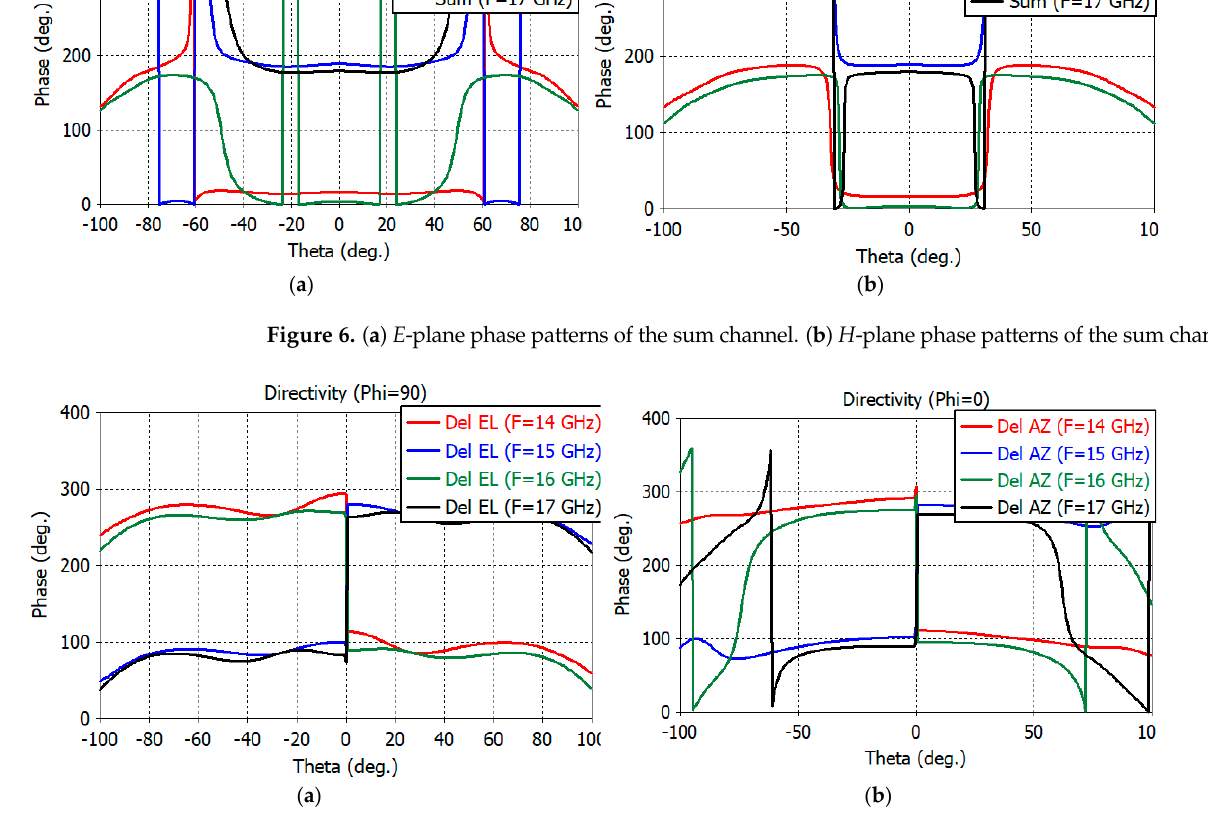
Figure 7. ( a ) Phase patterns of the elevation difference channel. ( b ) Phase patterns of the azimuth difference channel.